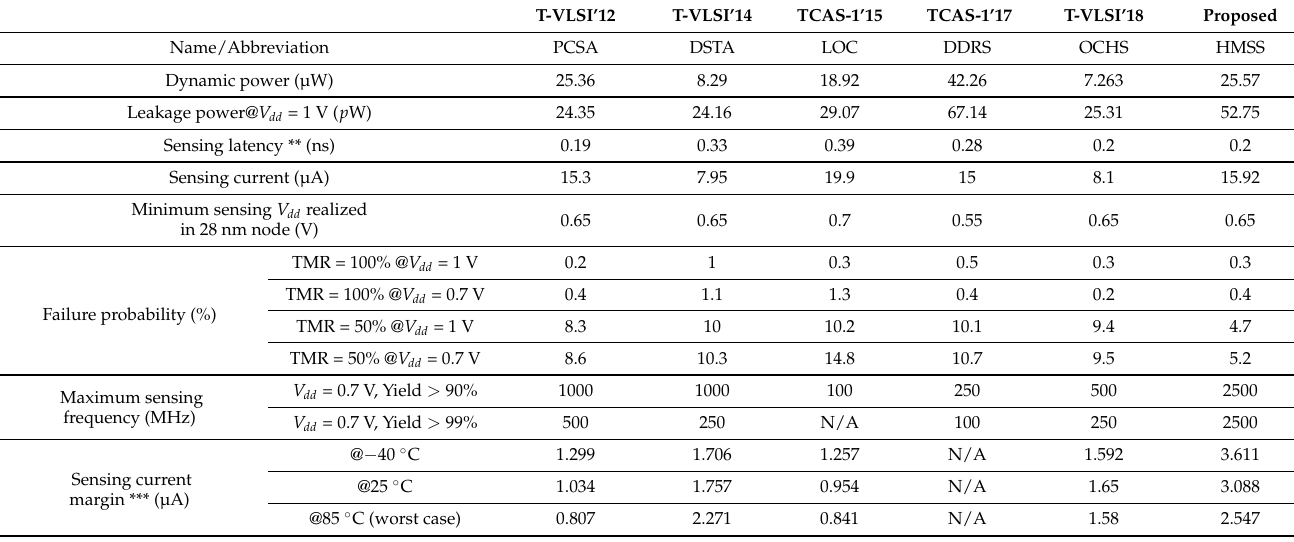
Table 3. Summary of Low-VDD sensing circuit performance ∗